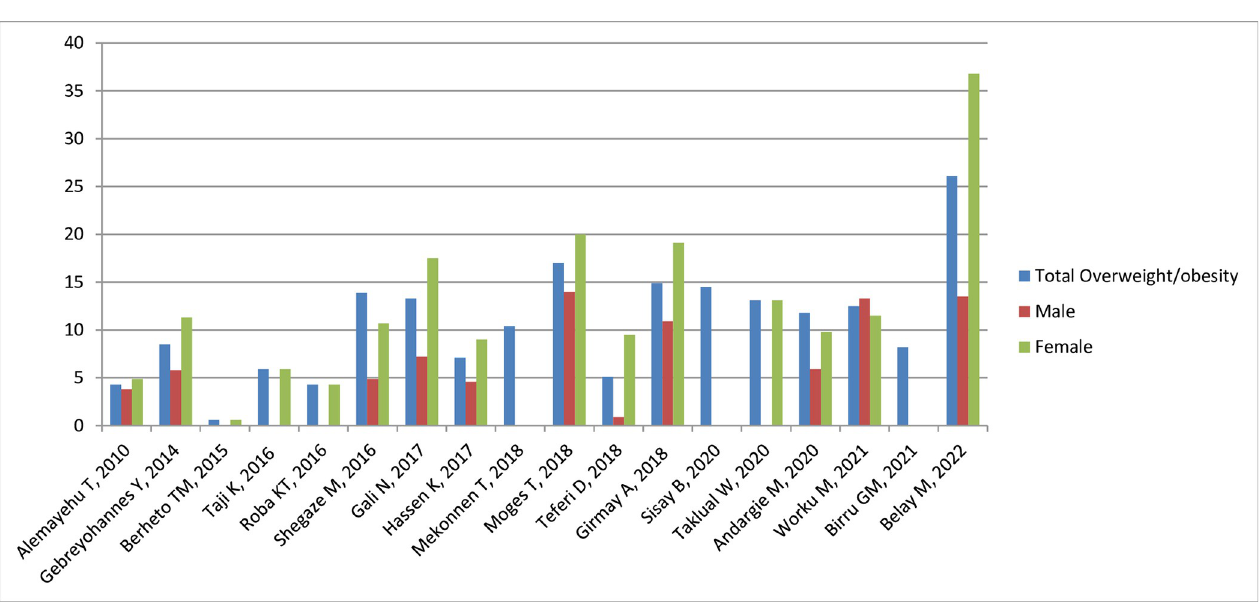
PLOS ONE | https://doi.org/10.1371/journal.pone.0280784 April 6,